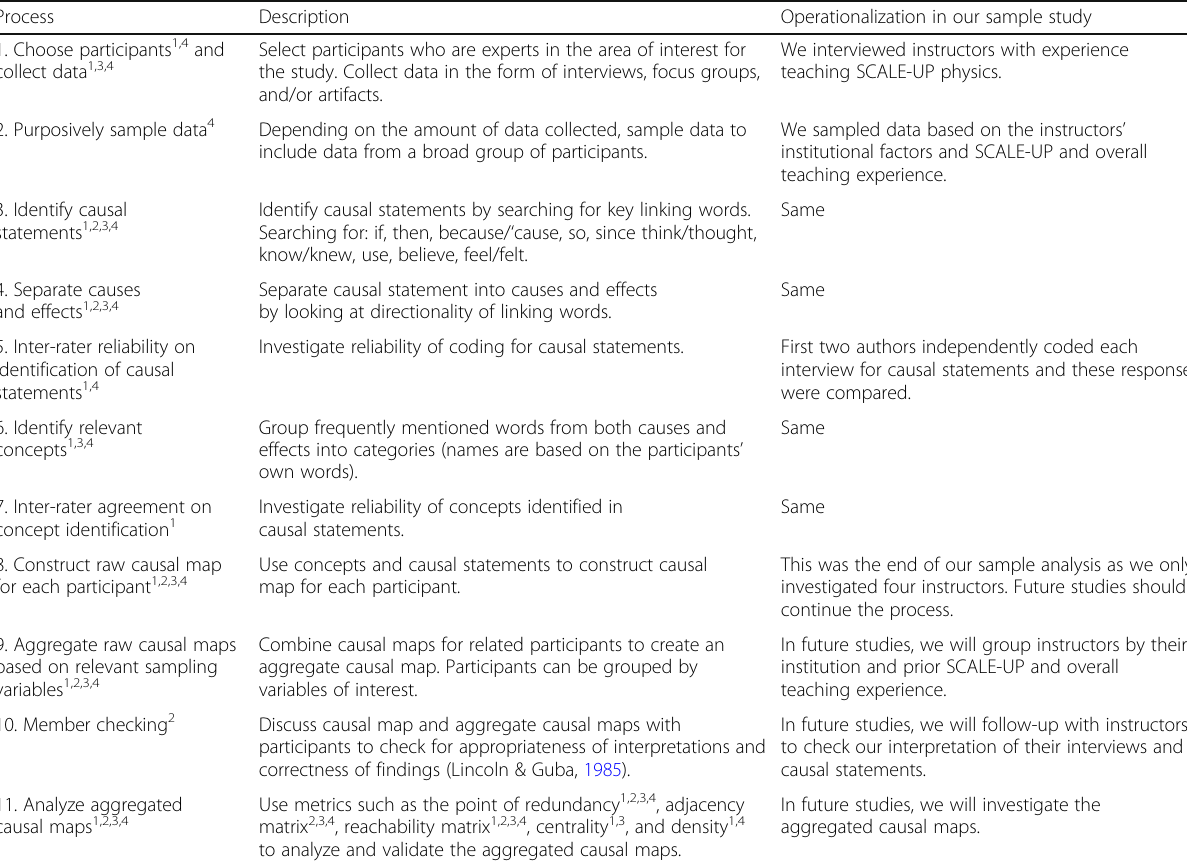
Table 5 Our Revealed Causal Mapping (RCM)